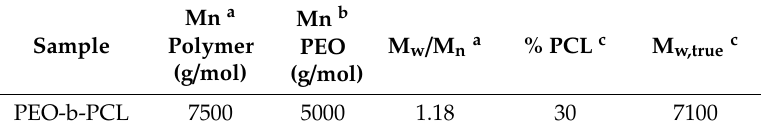
Table 1. Molecular characteristics of the PEO-b-PCL copolymer.